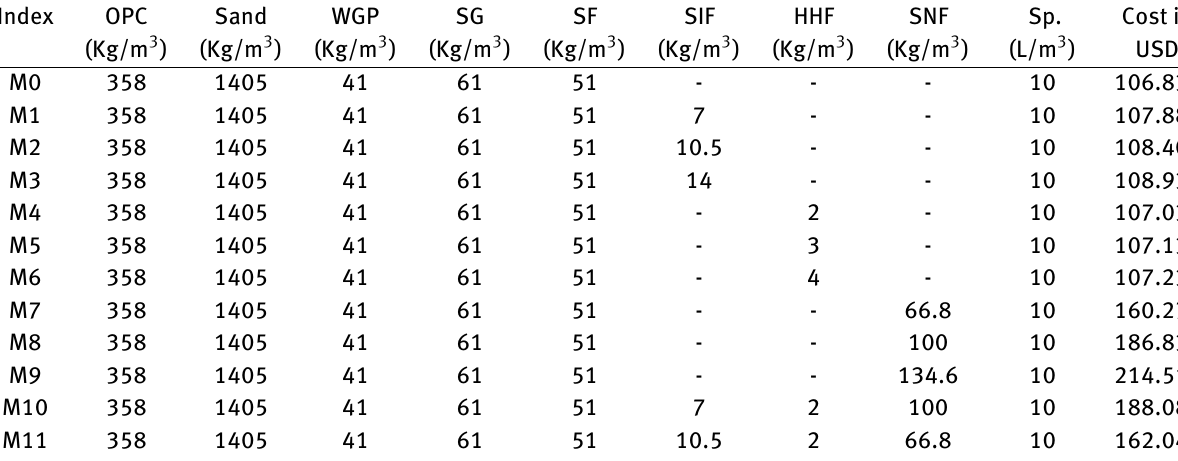
Table 12: Estimated cost of reinforced green